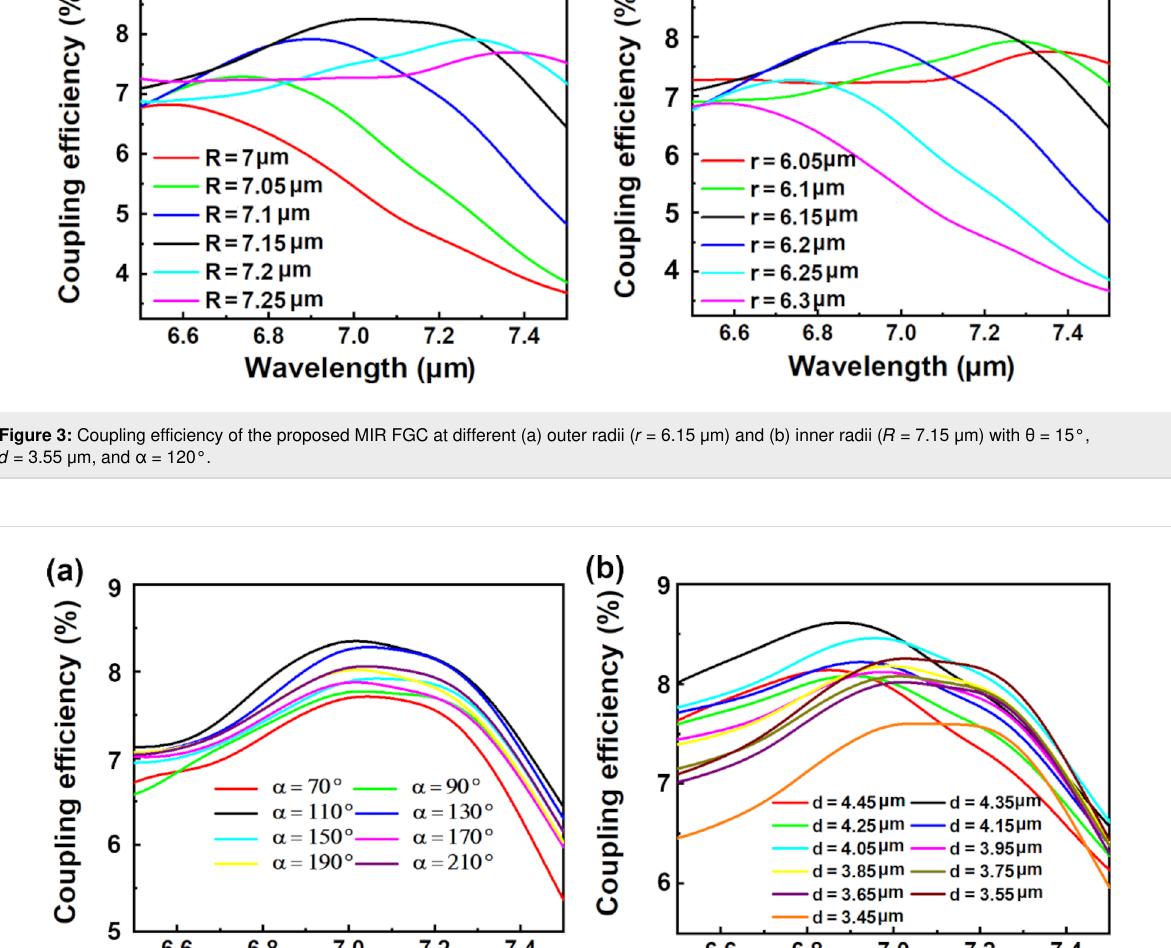
and the maximum coupling efficiency is 8.61% (6.878 μ